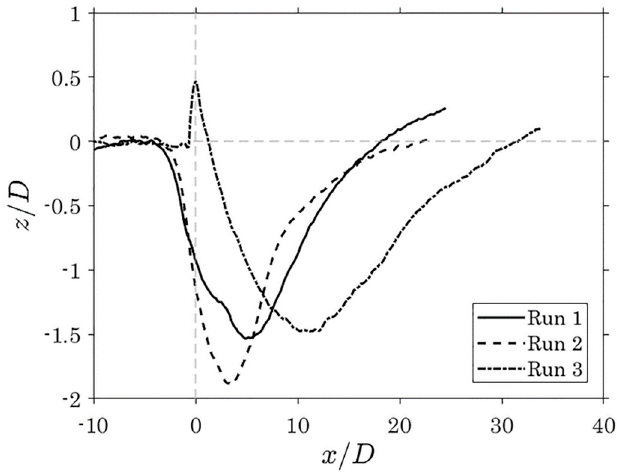
Figure 2. Centerline longitudinal bed profiles at equilibrium.